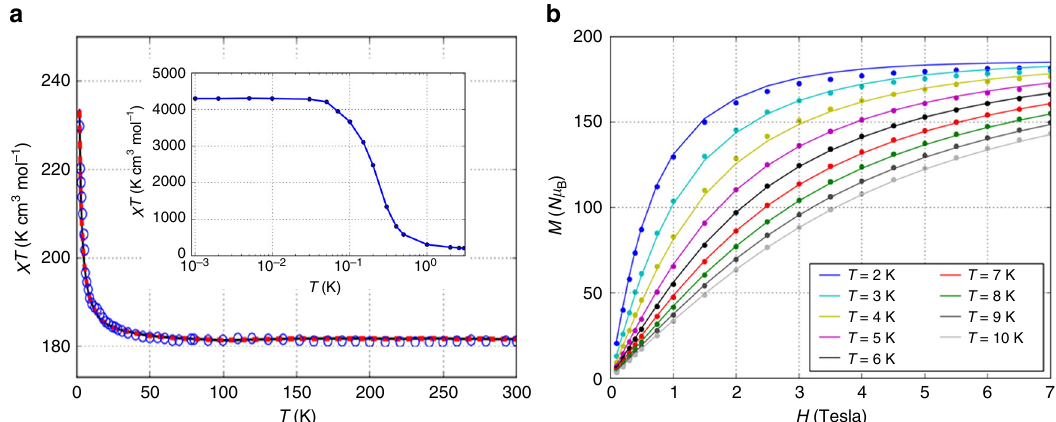
Fig. 2 The magnetic characteristics for compound 1. a The temperature dependences of χ T versus T . The experimental data are shown as circles, and the solid curve is for the single J -model, assuming D Ni = 0 with J / k B = – 0.033 K (best fi t). b Magnetization versus fi eld for several fi xed values of temperature using the single J -model (with D Ni = 0) that provides the best fi t to the susceptibility. The experimental data are shown as dots and theory data shown as solid curve. (Inset of a ) Low-temperature predictions of the isotropic Heisenberg model for χ T versus